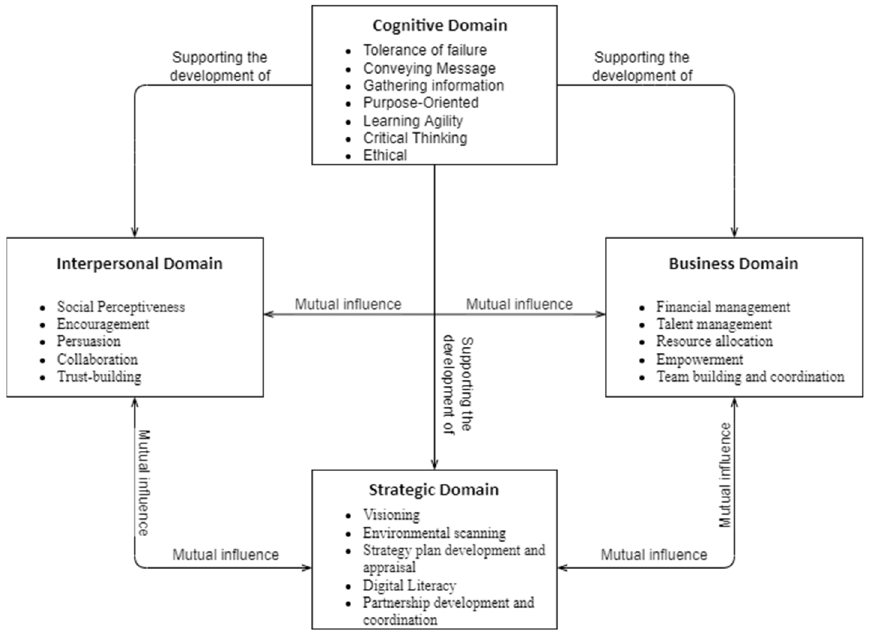
Figure 3. Key competencies in the context of Construction 4.0.